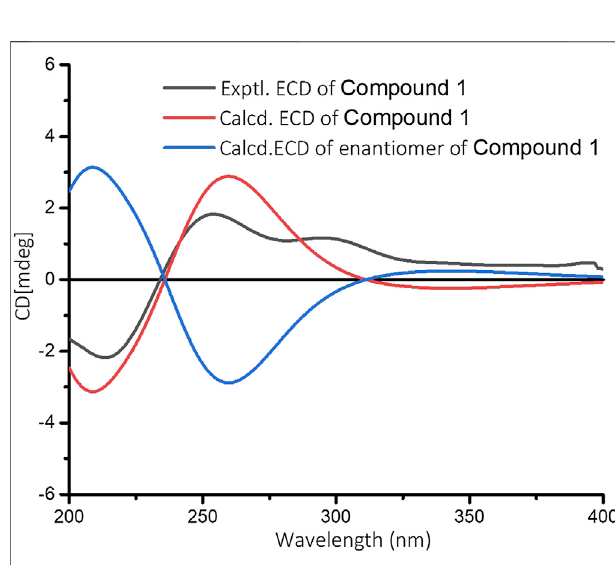
Frontiers in Chemistry |